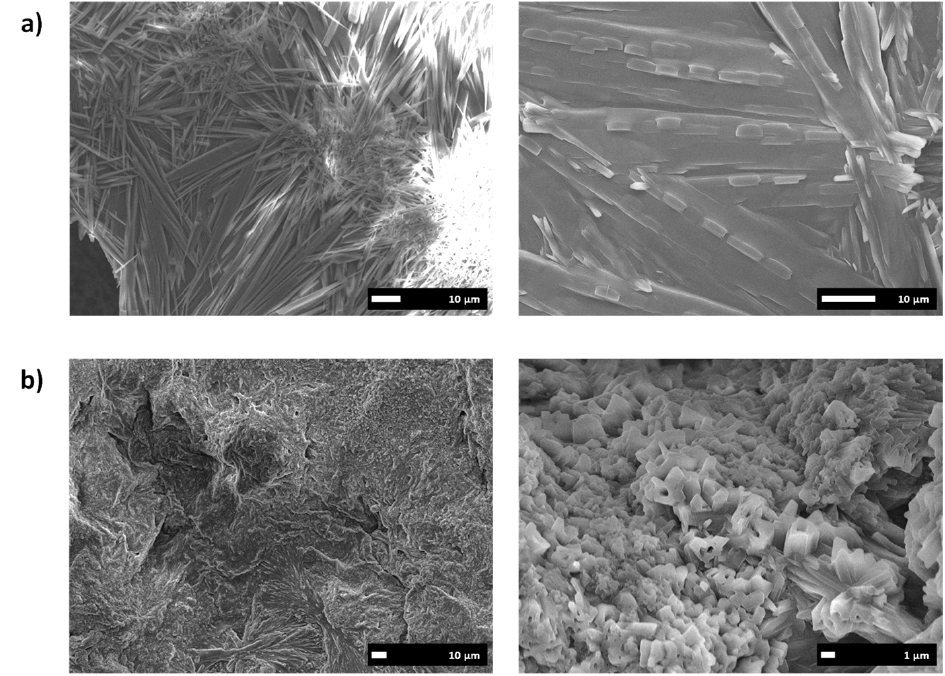
Figure 6. Sem pictures for the polymeric mats ( a ) Mat 7 (scale bars correspond to 10 μ m) ( b ) Mat 8 (scale bars correspond to left: 10 μ m, right: 1 μ m).